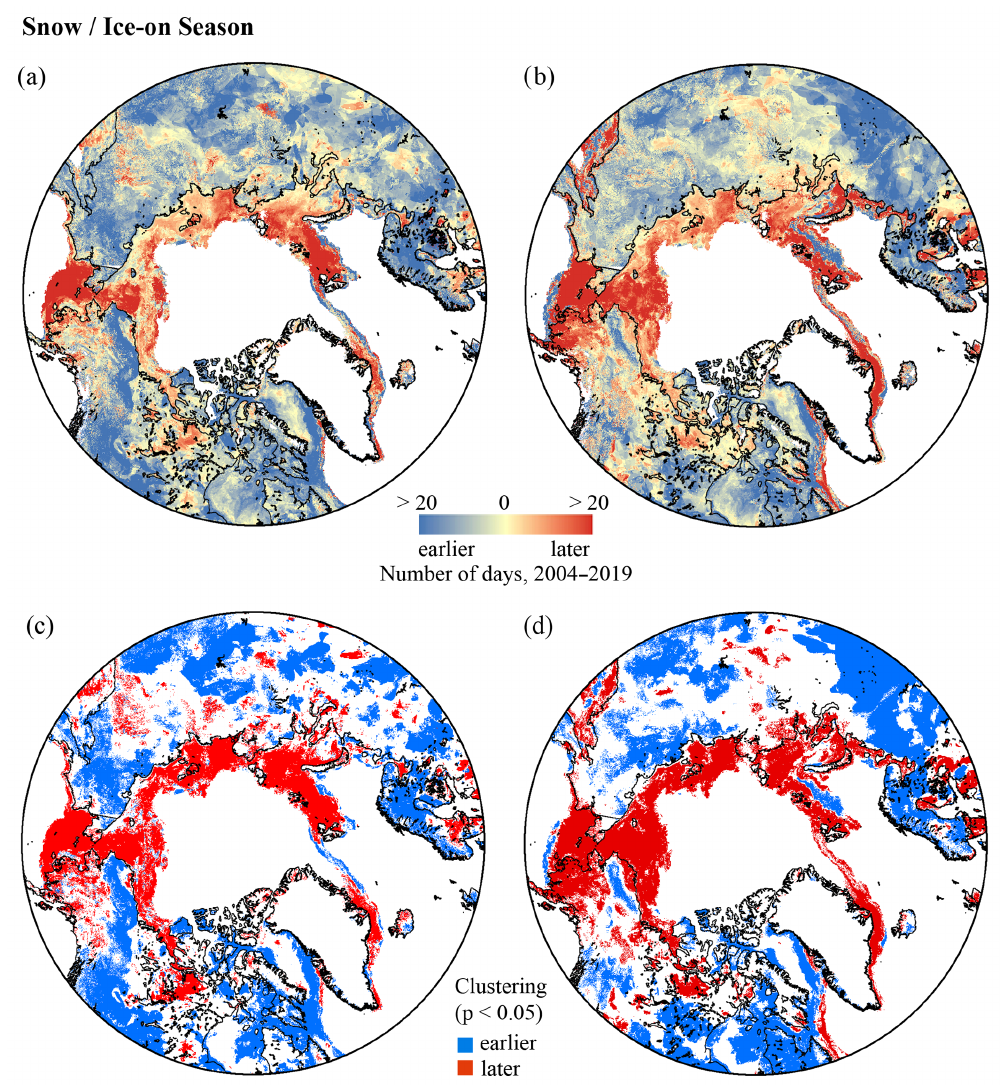
Figure 7. Trends in 4km IMS (2004–2019) (a) sea ice freeze onset (FO S ), first snow-on (first_s ON ), and lake ice freeze onset (FO L ); (b) and sea ice continuous ice cover (CIC S ), final snow-on (final_s ON ), and lake ice continuous ice cover (CIC L ); (c) significant trend clusters in FOs, FO L , and first_s ON ; and (d) significant trend clusters in CIC S , CIC L , and final_s ON